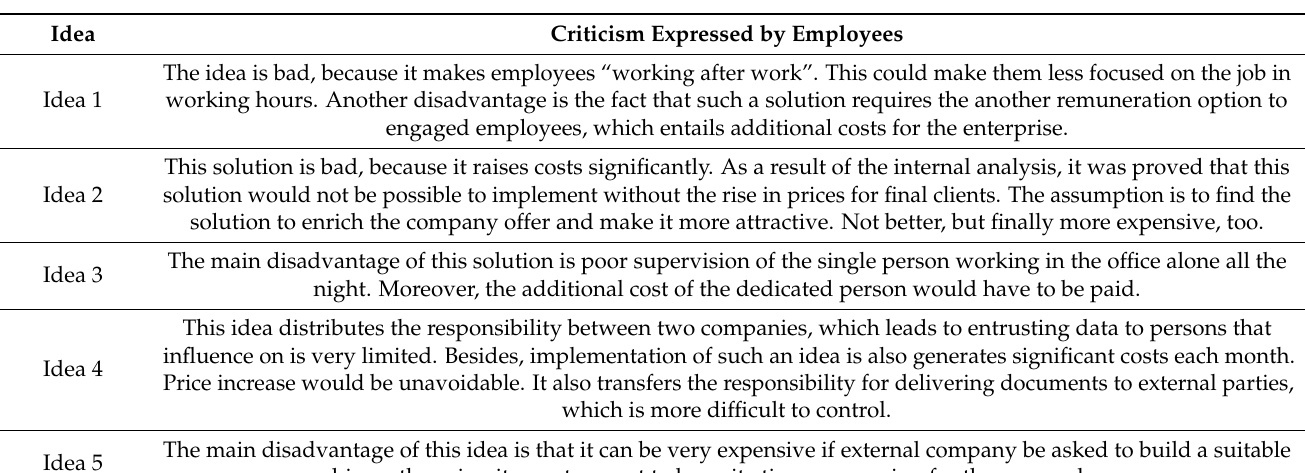
Table 2. The critical approach to the ideas emerged during the brainstorming session. Idea Criticism Expressed by Employees Idea